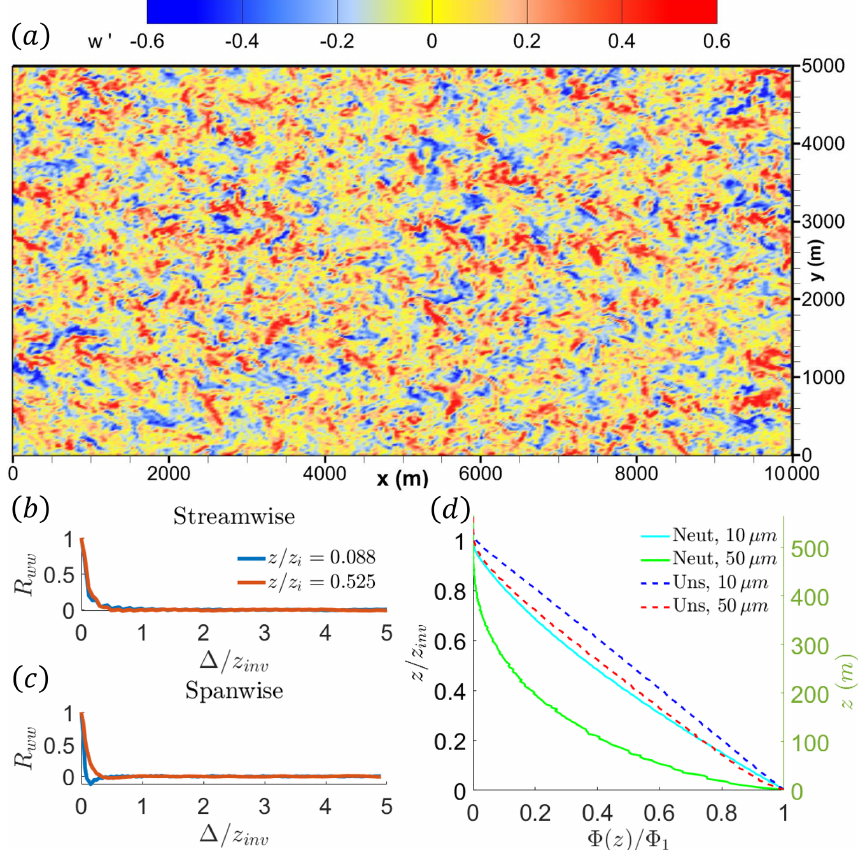
Figure 12. Characteristics of the simulated neutral boundary layer. The top panel (a) is the snapshot vertical velocity field at z/z inv = 0 . 525. The bottom left panels are the spatial correlation at heights z/z inv = 0 . 083 and z/z inv = 0 . 525 for both streamwise (b) and spanwise (c) directions. The bottom right panel (d) is the planar-averaged vertical flux profile for 10µm and 50µm diameter aerosol particles. “Neut” stands for the neutral boundary layer configuration, while the dashed references represent the previous unstable boundary layer configuration (abbreviated as